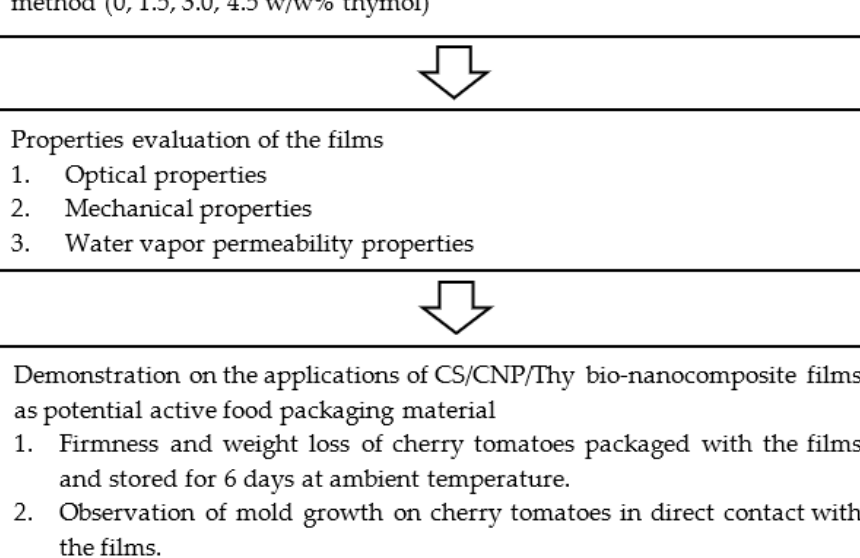
Figure 1. Summary of procedures for the development of corn starch/chitosan nanoparticles/thymol (CS/CNP/Thy) bio-nanocomposite films as potential active food packaging material.